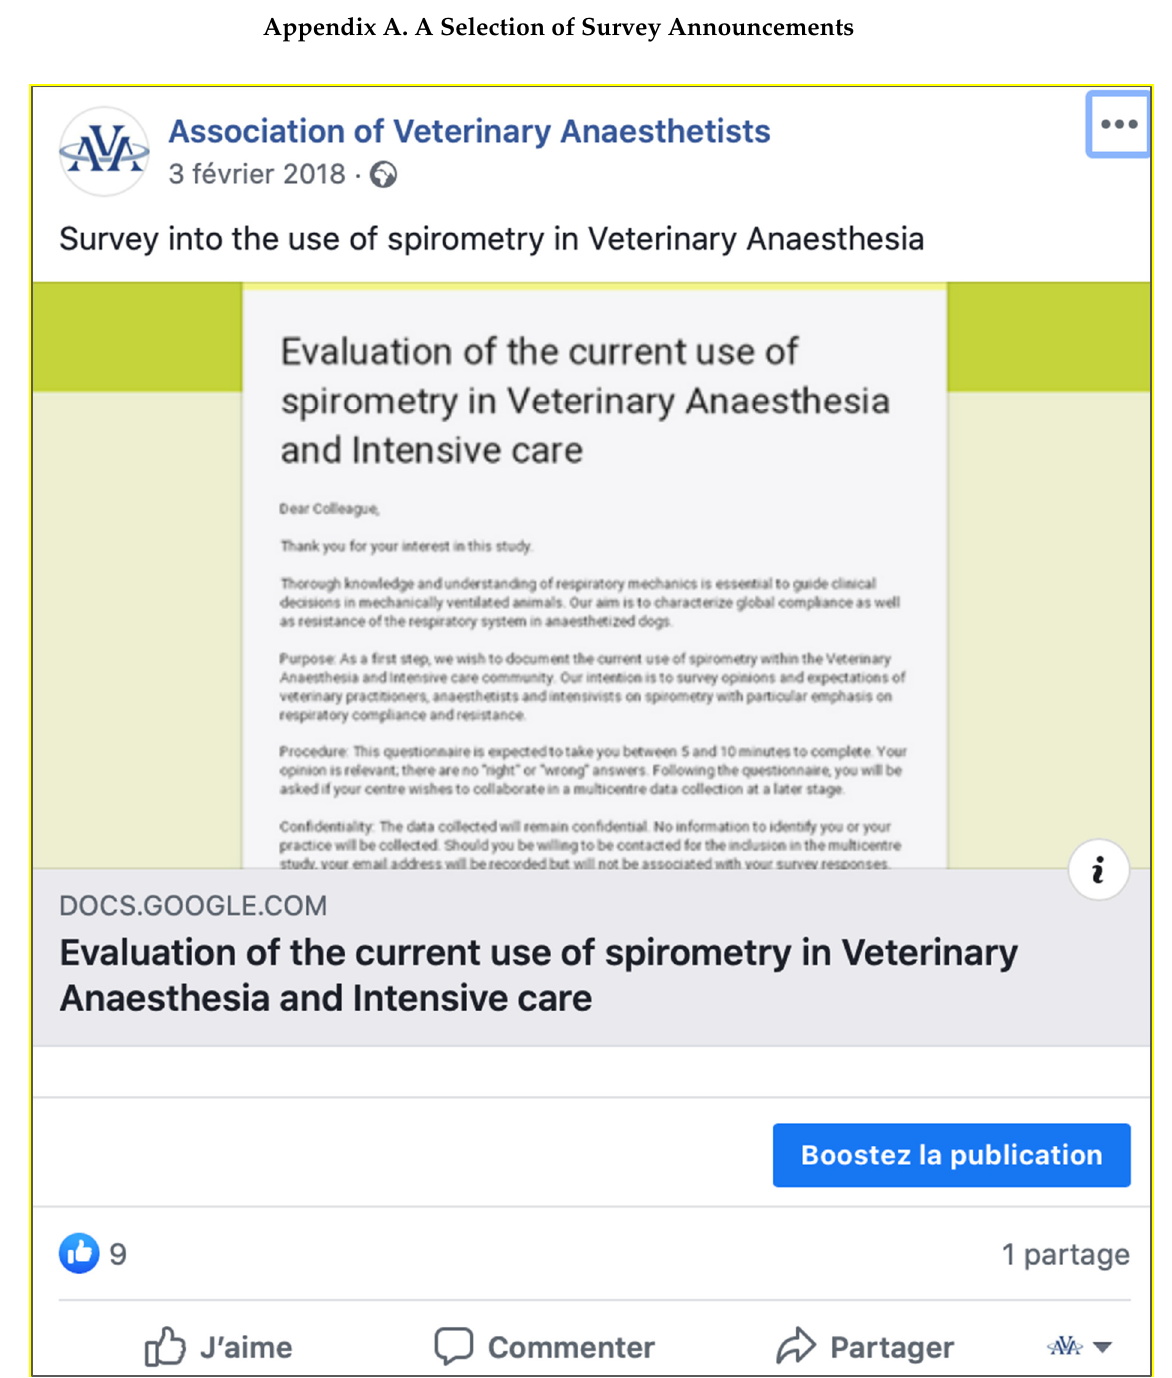
Figure A1. Example of survey announcement on the Facebook page of the Association of Veterinary Anaesthetists (AVA).